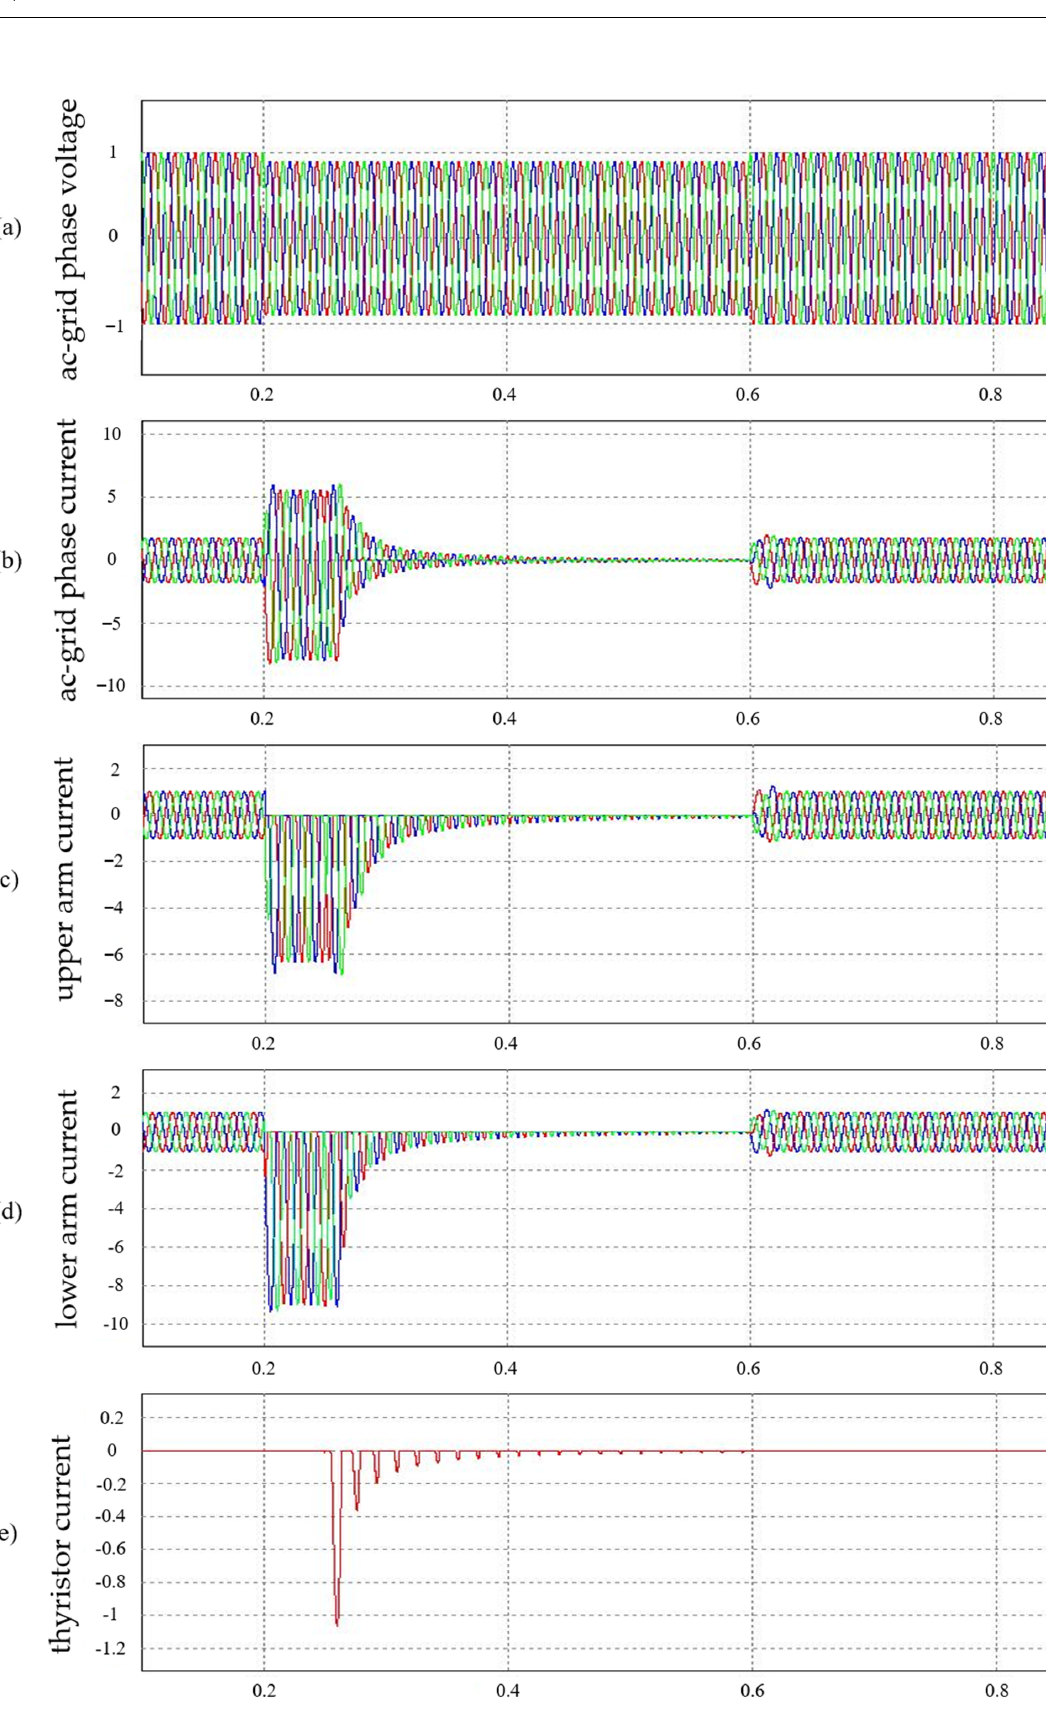
Figure 14. Simulation results of an MMC with the proposed sub-module. Figure 14c,d shows the waveforms of the upper and lower arm currents, respectively. The same principle as the AC is applied to the arm current in the short circuit , with the total voltage value in a closed loop being clamped to zero according to the control operation at approximately 0.25 s after the current rises, which decreases the arm current accordingly. The control operation starts with the operation signal of the thyristor. Figure 14e shows the waveform of the thyristor. The current path through the sub-module flows through the thyristor while forming capacitor voltage in all the sub-modules. The internal device of the sub-module is protected by the path bypassing the transistor switch. Figure 15a–d shows the waveform of the AC depending on the capacitance magnitude of the sub-module. The sub-module capacitance does not have a significant effect on the peak value of the fault current; nevertheless, it affects the clearance and recovery times depending on its magnitude. That is, as the capacitance gradually increases, the clearance and recovery times of the current in the AC and DC side are relatively increased after the FRT control operation is performed.